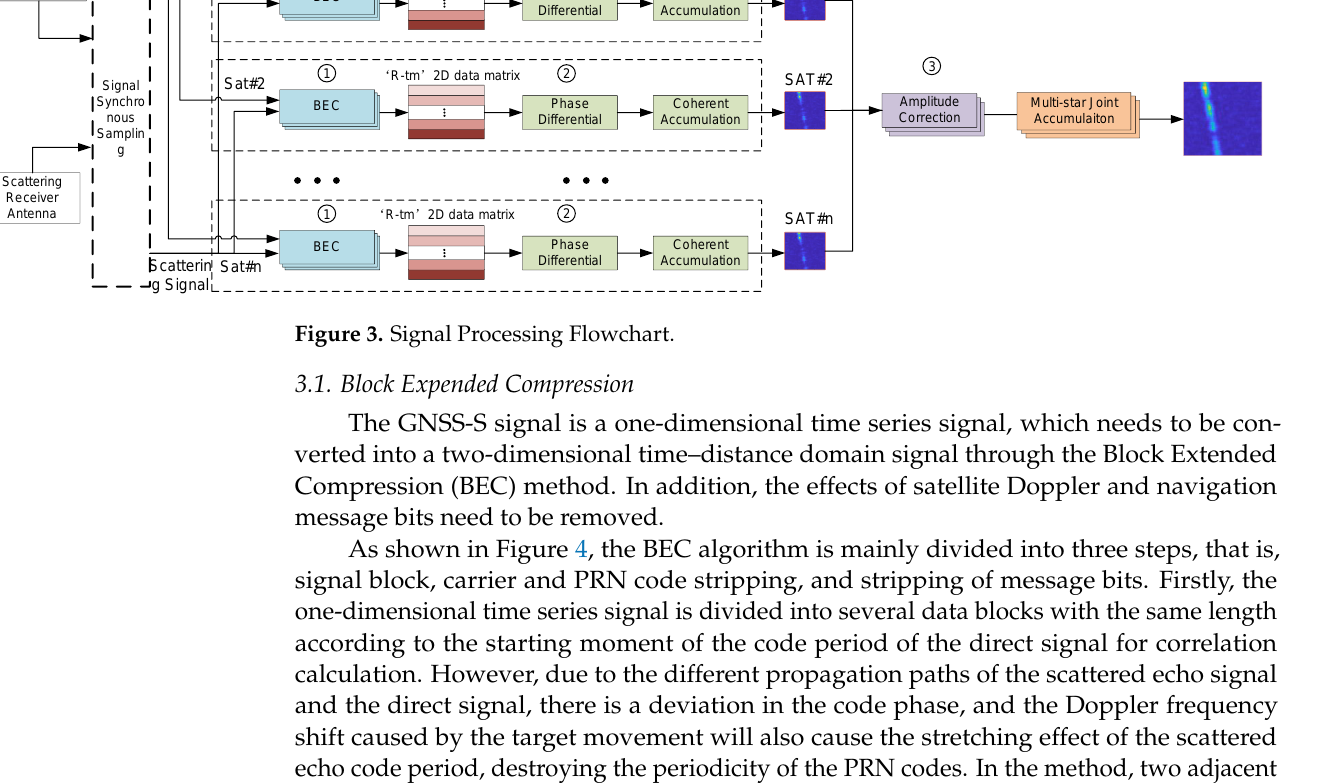
C o d e P e r i o d Figure 5. Schematic diagram of block operation. (b) Expansion operation. The expansion of the copy signal of the direct signal is di- vided into two parts. One is to splice two adjacent carrier data sub-blocks; the other is to add zero blocks to each sub-block of the PRN block, the length of which is the same as the next sub-block. The expansion of the scattered echo signal is to splice every two adjacent sub-blocks together to form a new data block.